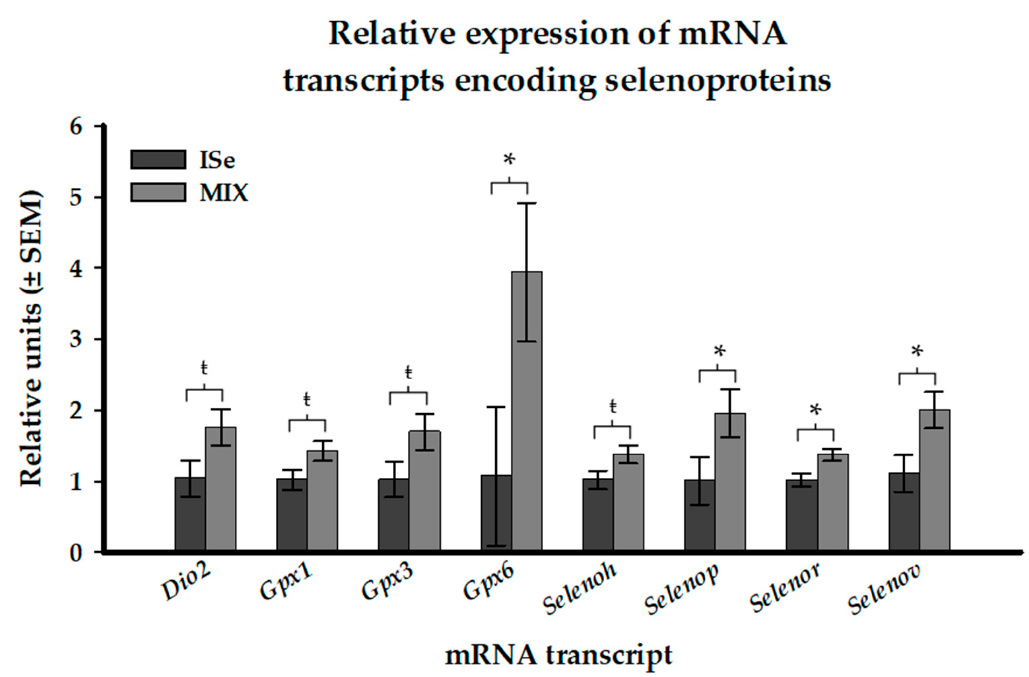
Figure 3. Effect of form of Se on the expression of mRNA transcripts encoding selenoproteins in the CL of cows supplemented with vitamin mineral mixes containing Se as ISe (sodium selenite; n = 5) or a 1:1 combination (MIX) of ISe and OSe (Sel-Plex; n = 5). p -values are associated with Student’s T- Test. Significant differences at p < 0.05 are indicated by an asterisk and tendencies at 0.05 ≤ p < 0.1 are indicated by ŧ . Table 1. Relative abundance of mRNA encoding selenoproteins and selenoprotein P receptors in the CL of cows supplemented with vitamin-mineral mixes containing Se as sodium selenite (ISe, n = 5) or a 1:1 equimolar mix of ISe and OSe (MIX, SEL-PLEX, n = 5) 1 .